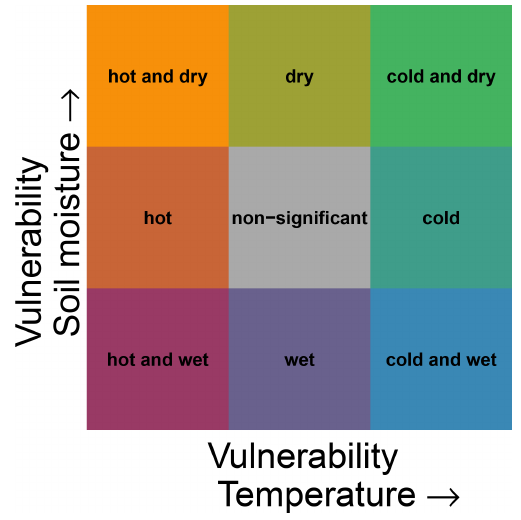
Figure 3. Illustration of the vulnerability to all potentially occurring climatic